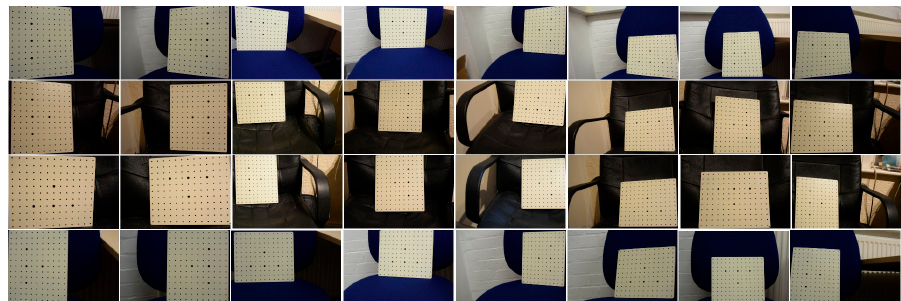
Figure 3. Images used for zoom lens calibration of Nikon 1 J4.